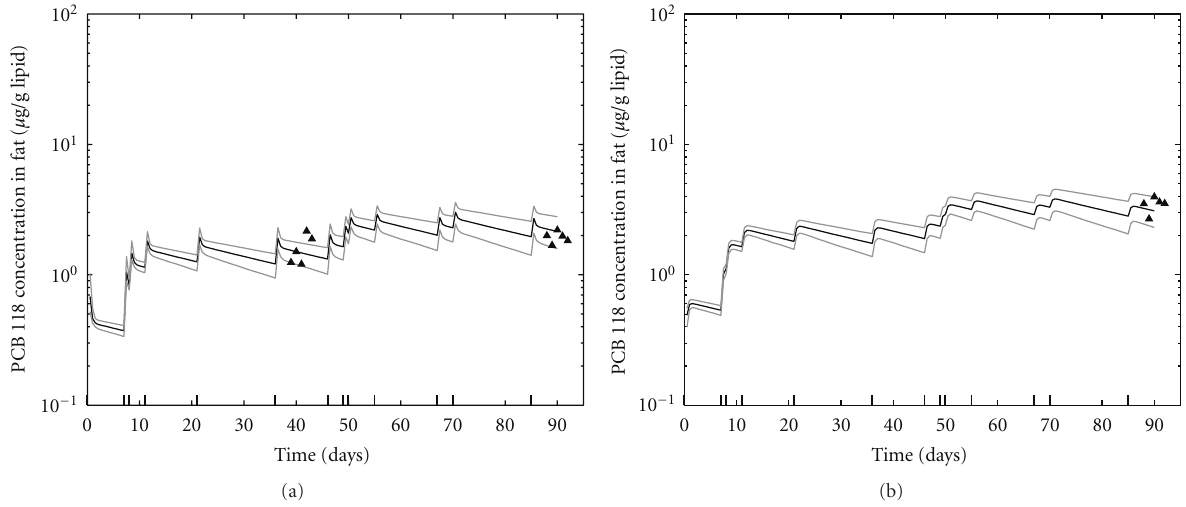
Figure 4: Model predictions for PCB 118 in liver (a) and fat lipids (b) for the nonperiodic dose scenario at the 50 μ g/kg dose level. Data for all rats are shown (black triangles), and measurements for each rat at time of sacrifice have been shifted slightly on the x -axis. Modeled results are the median and 95% confidence interval of 1000 model runs using parameters randomly sampled from the posterior distribution.